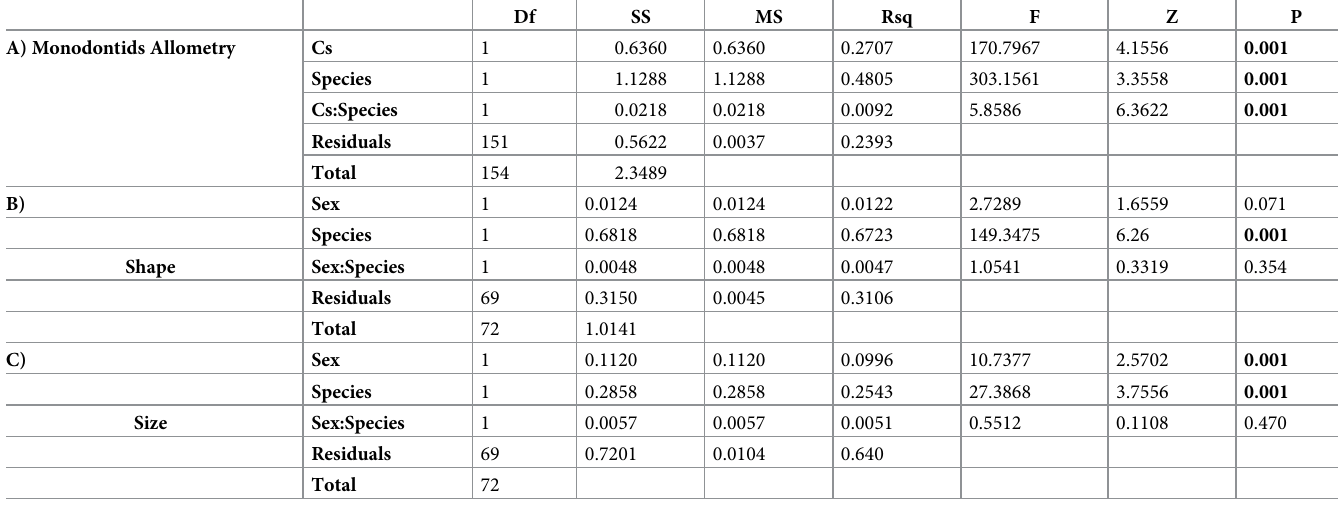
Table 3. Procrustes ANOVA to test for A) allometry in 155 monodontids excluding the known and putative hybrid; B) sexual shape dimorphism (SShD) and C) size (SSD) dimorphism on crania shape of 73 sexed monodontid